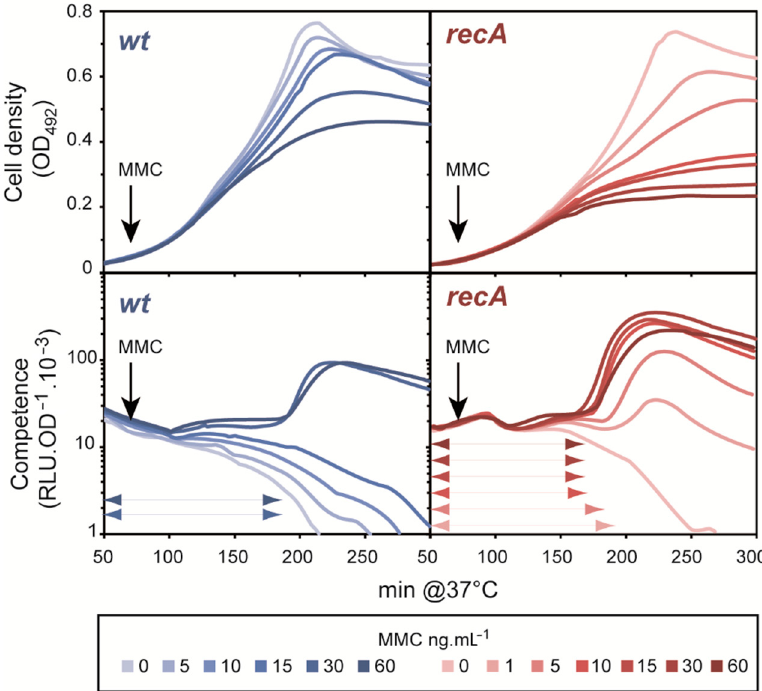
Figure 2. The lack of RecA exacerbates MMC-mediated competence induction. WT and rec A − cells were cultivated in C+Y medium adjusted to a pH non-permissive for spontaneous competence development. Cell density (OD 492 ) is shown in the upper panels and competence gene expression (RLU.OD 492 − 1 × 10 3 ) in the lower panels recorded every 10 min. After 70 min of growth, MMC was added at the indicated concentrations, shown as light grey-blue to dark grey-blue for WT cells and light brown to dark brown for recA − cells. The curves represent the mean of two replicates. Standard deviations are omitted for clarity. Double arrowheads depict the X A period.